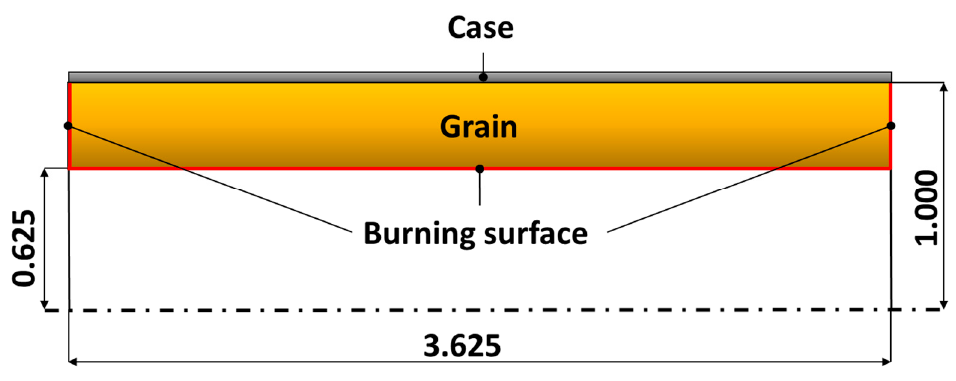
Figure 10. BARIA motor schematics [12].